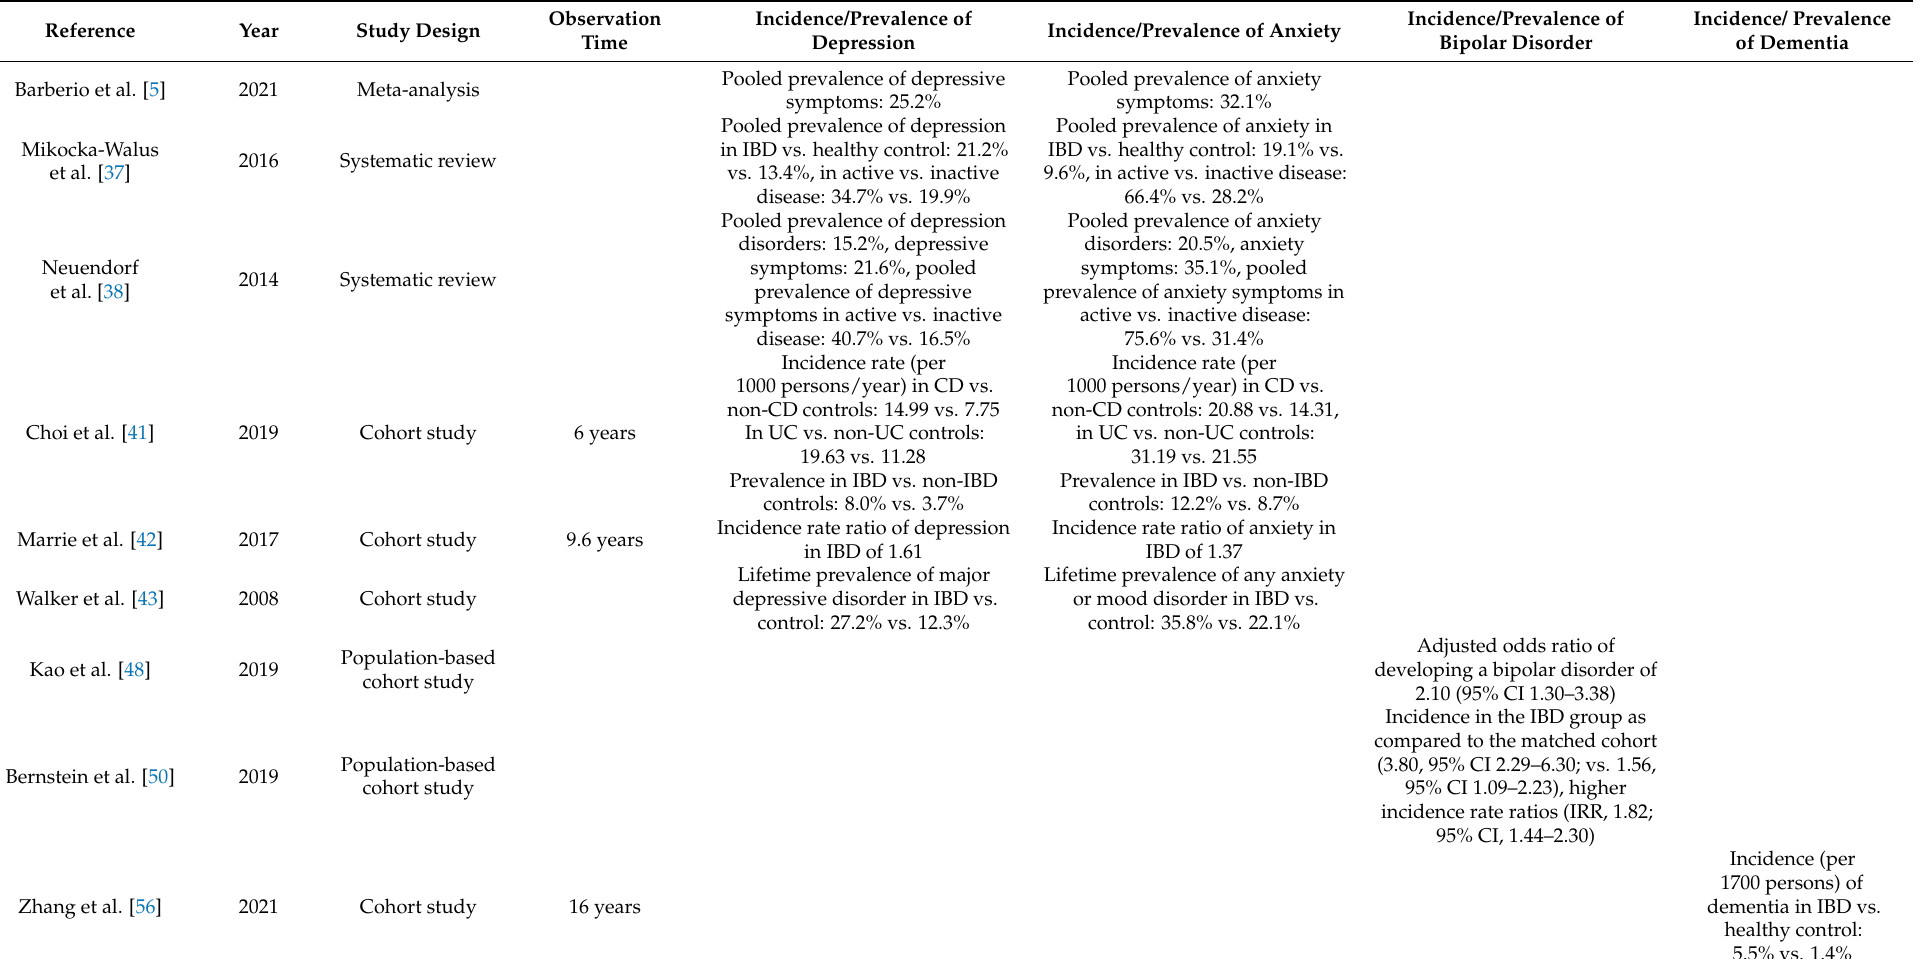
Table 1. Data on incidence and prevalence of mental illnesses in IBD. IBD: inflammatory bowel disease; UC: ulcerative colitis; CD: Crohn’s